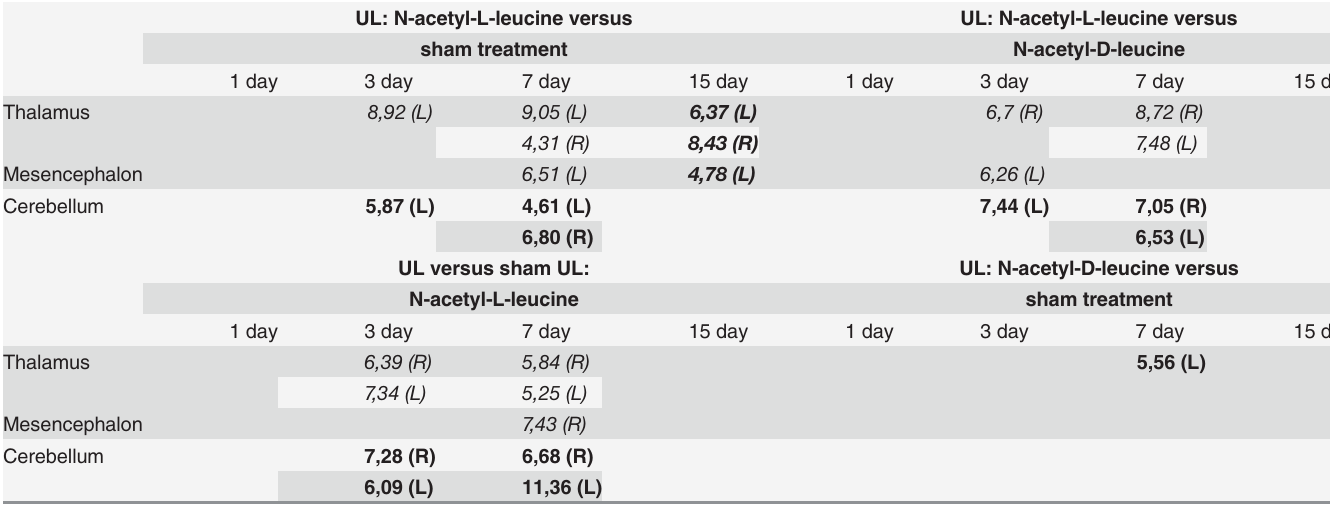
Top left: comparison of N-acetyl-L-leucine and sham treatment following unilateral labyrinthectomy (UL); top right: comparison of N-acetyl-L-leucine and N- acetyl-D-leucine treatment following UL; bottom left: comparison of N-acetyl-L-leucine treatment following UL and N-acetyl-L-leucine treatment following sham UL; bottom right: comparison of N-acetyl-D-leucine and sham treatment following UL. Decrease of rCGM is depicted in Italic, increase in Bold. The signi fi cance of the clusters is depicted by t-values at a p-value of 0.001. Degrees of freedom: (n 1 – 1)+(n 2 – 1) L left side, R right side